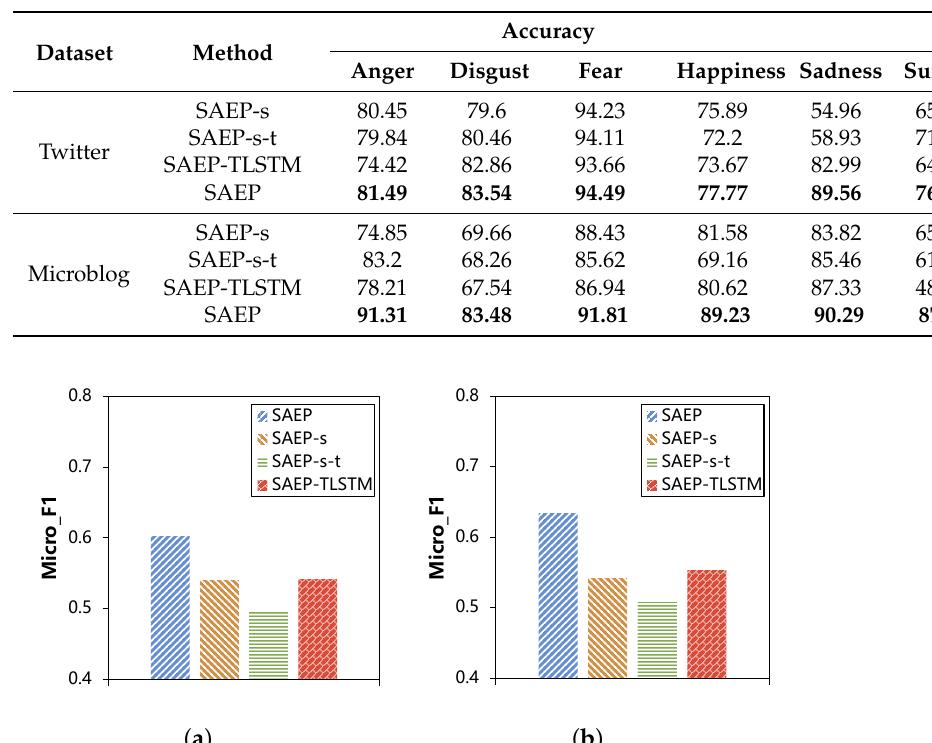
Table 3. Ablation analysis on two datasets.